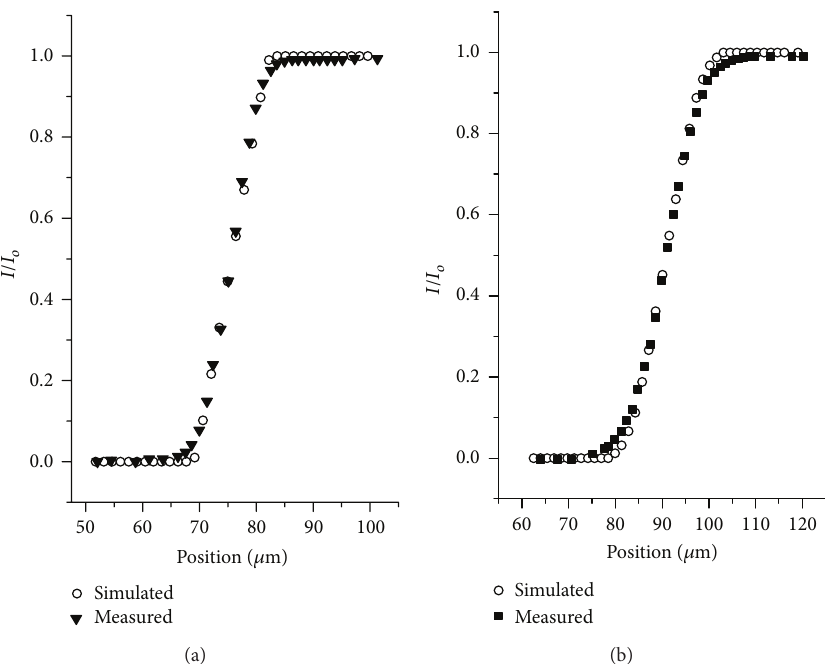
Figure 5: Measured and simulated vertical profile of the microbeam: (a) at 1mm and (b) at 10mm. In (a) the mean FWHM for the simulated beam is 22.1 𝜇 m and the measurement gives 22.3 𝜇 m. For (b) the mean FWHM for the simulated beam is 34.5 𝜇 m and the measurement gives 34.7 𝜇 m.